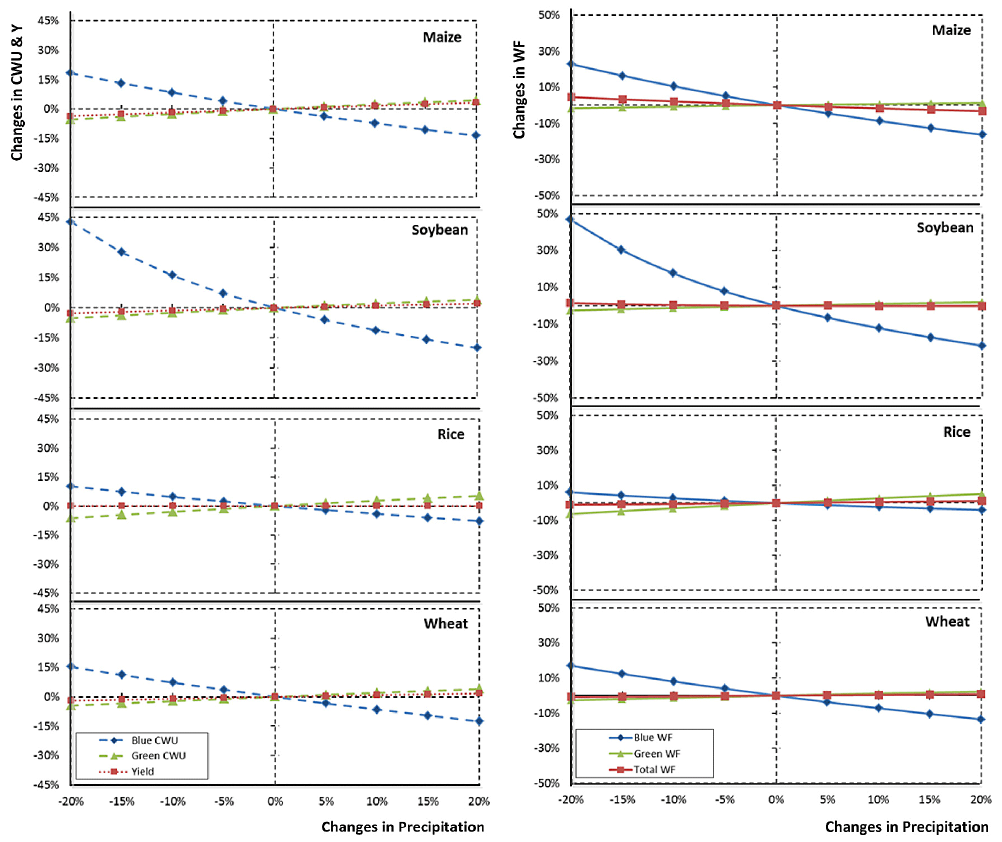
Figure 3. Sensitivity of CWU, Y and WF to changes in precipitation (PR), 1996–2005.